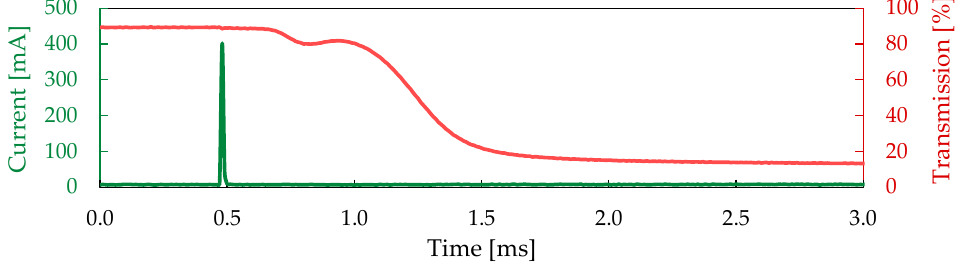
Figure 13. Current through the cell.